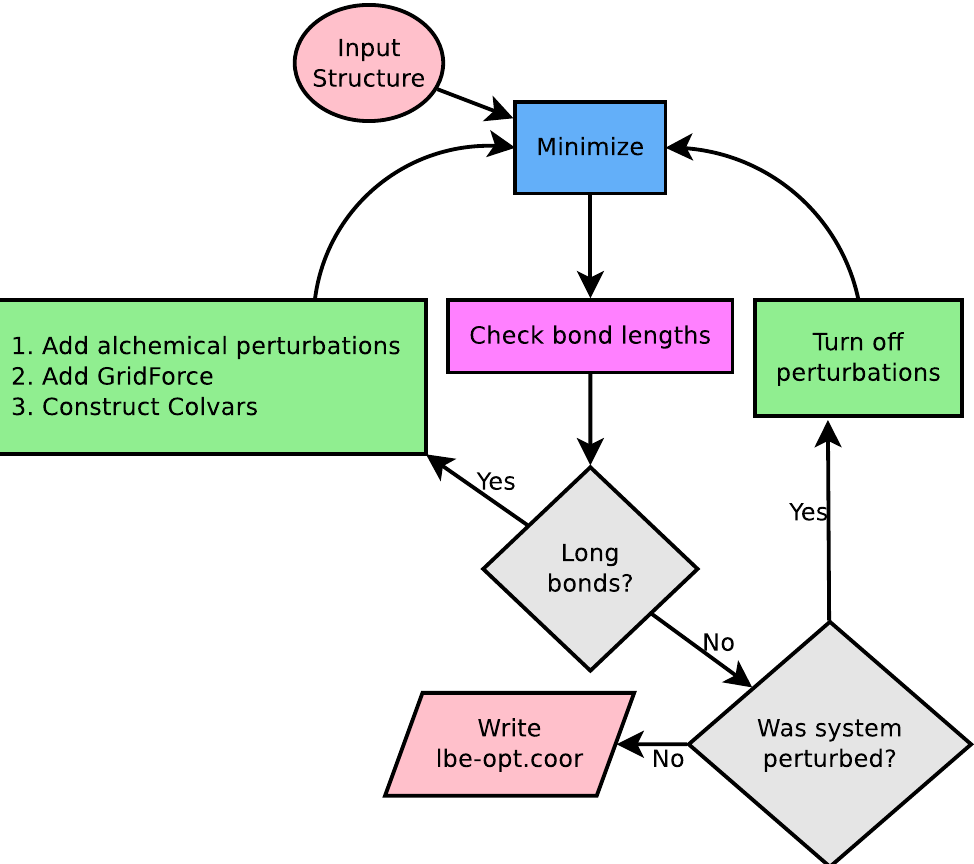
Figure 2. Logical flow diagram guiding the cycle for iterative minimization. A working NAMD configuration file is essentially the only input, providing an input structure, coordinates, and parame- ters. NAMD is used for minimization (blue square), and the primary analysis computes the bond lengths from simulation (pink square). The flow control is handled by the gray diamonds, which first compares the computed bond length against the equilibrium bond length in the simulation force field, and if no bonds are detected, asks if the previous simulation run had alchemical perturbations turned on. Modifications to the original NAMD configuration file are highlighted in green. If long bonds are detected, multiple features are added to the NAMD configuration file to relax the structure. Otherwise, if the previous simulation was perturbed, another minimization round is carried out without alchemical perturbation features enabled. When the procedure completes, we write a set of output